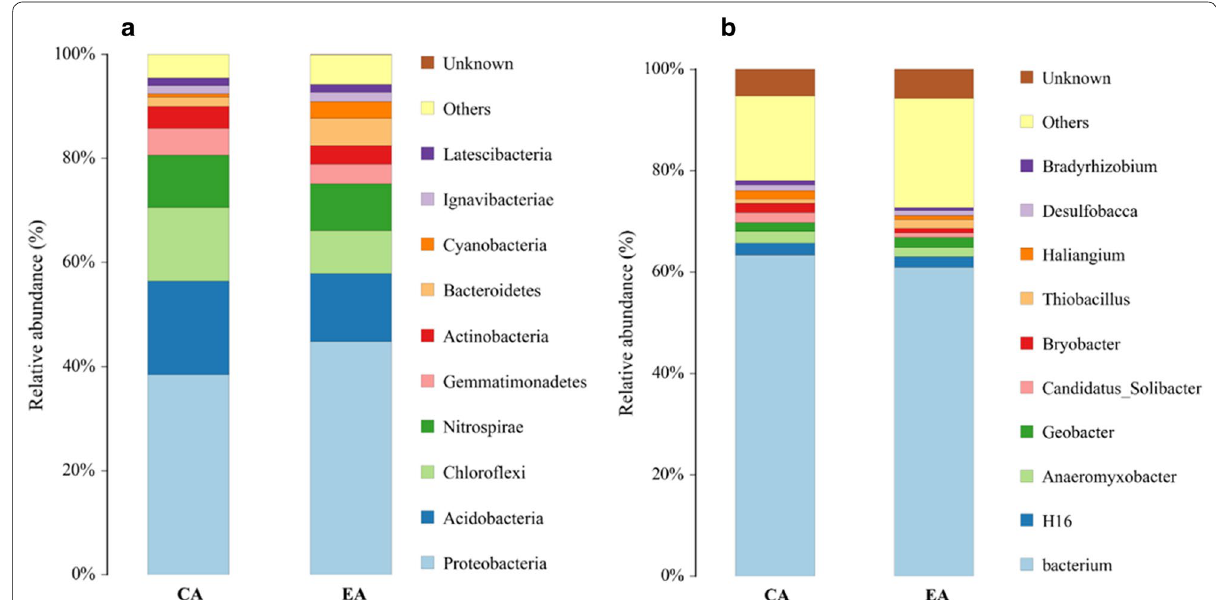
Fig. 4 The relative abundance (%) of bacteria identified by Illumina high-throughput sequencing at the phylum ( a ) and genus ( b ) levels. CA represents conventional agriculture, and ecological agriculture is abbreviated as